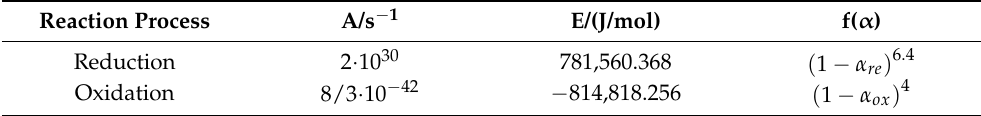
Table 4. Results of kinetic triplet